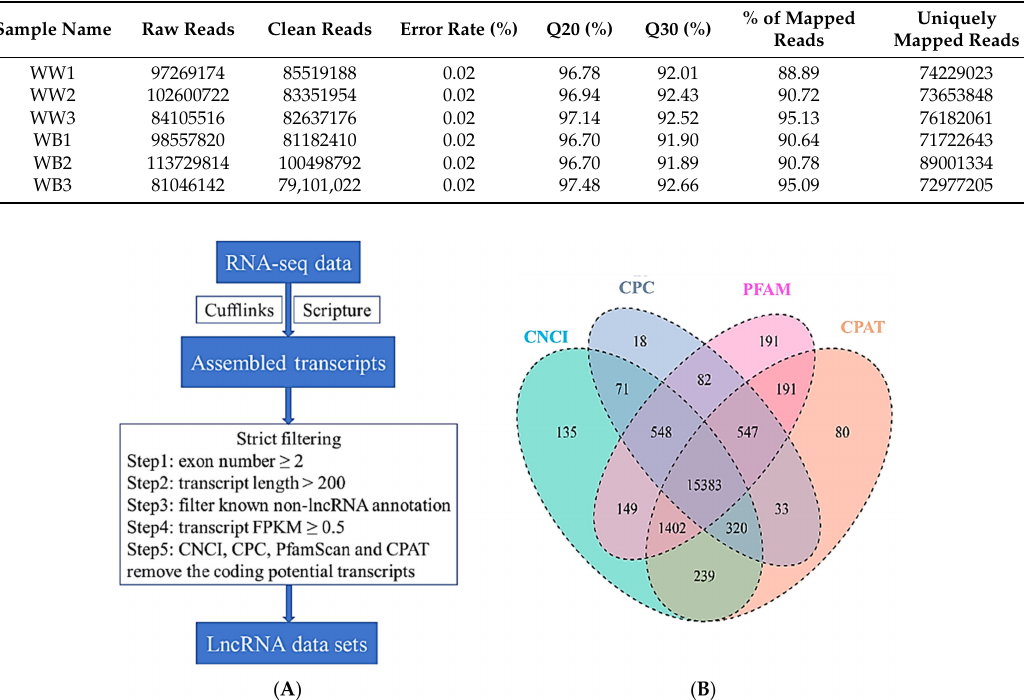
Table 2. Statistical summary for RNA sequencing results.